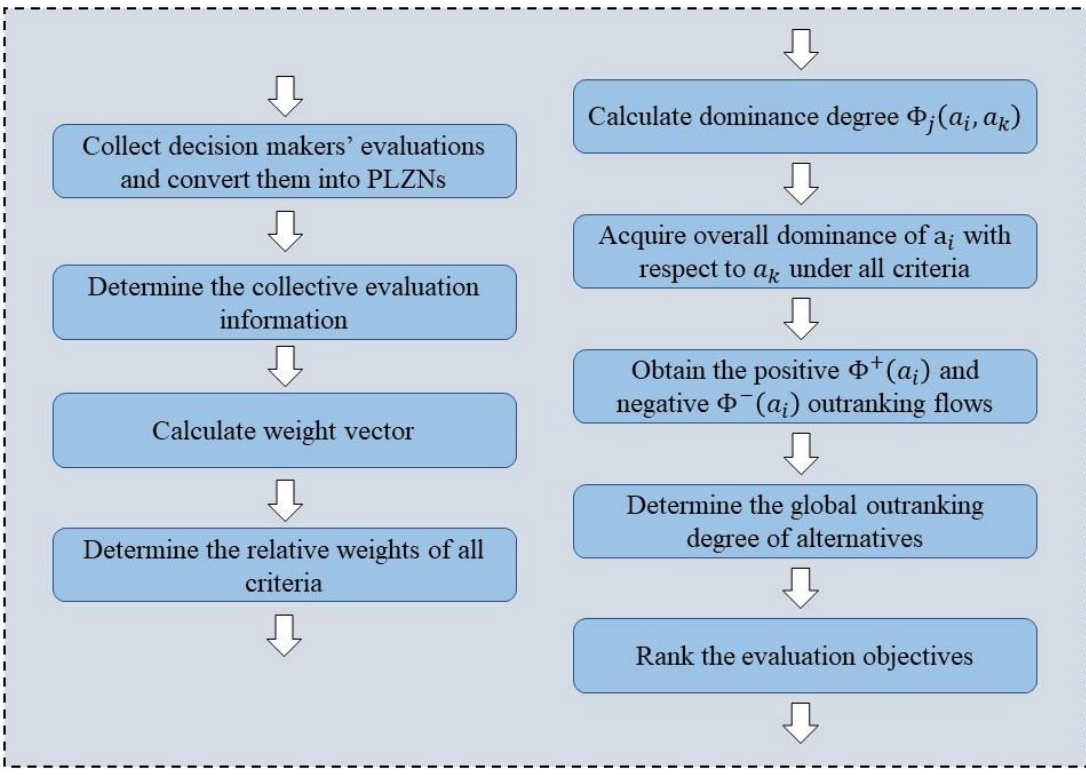
Figure 1. Flow chart of the decision support framework.